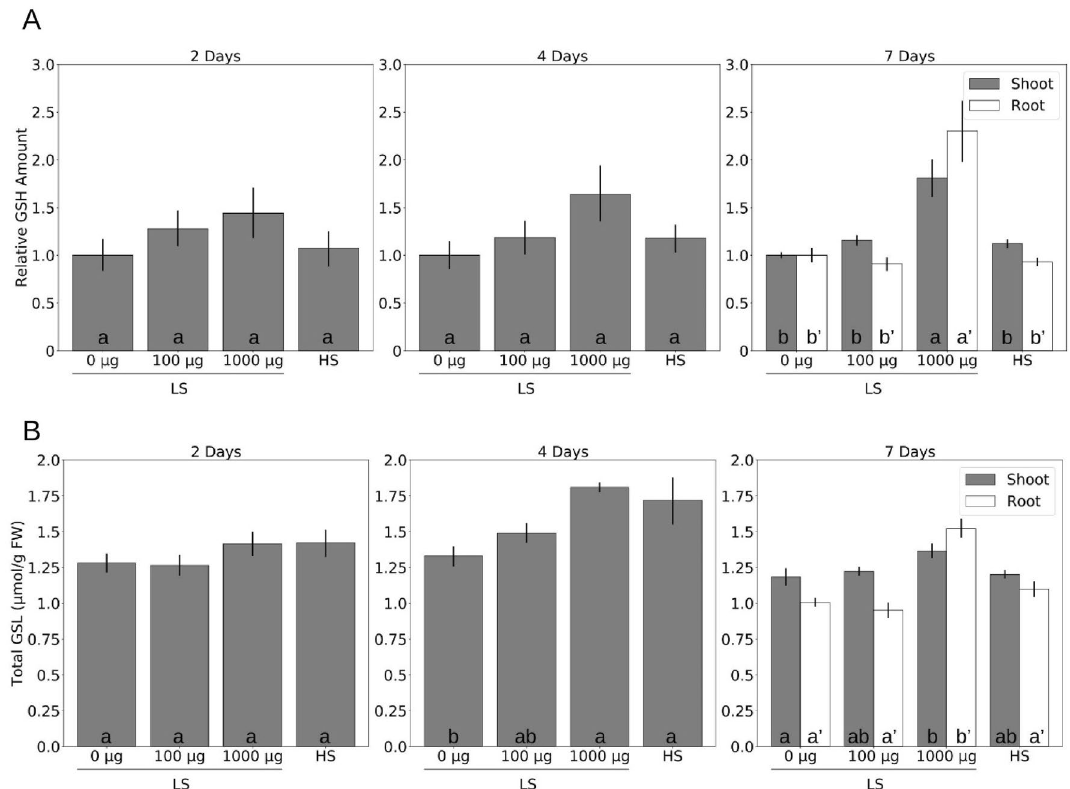
Figure 6. TMTM maintains sulfur-containing metabolites under sulfur deficiency. ( A ) Relative glutathione (GSH) level and ( B ) total glucosinolate (GSL) level in seedlings grown on low sulfate (LS) MGRL medium with addition of TMTM (0, 100 and 1000 µg) and seedlings grown on high sulfate (HS) MGRL medium 2, 4 and 7 days after treatment. Error bars represent SEs from at least 5 biological replicates, each with 8 seedlings. Statistical significance was determined by Duncan’s multiple range test with p-value < 0.05, and indicated with lower-case